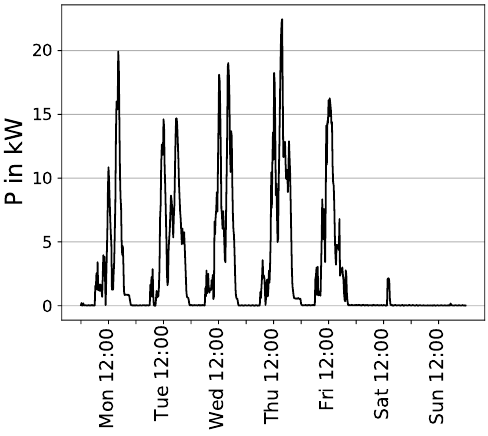
Figure 4. Weekly charging profile for the agency site.